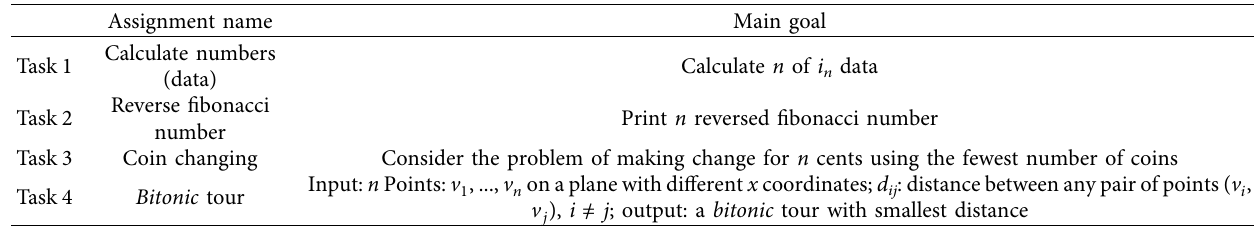
Table 6: Static programming assignment